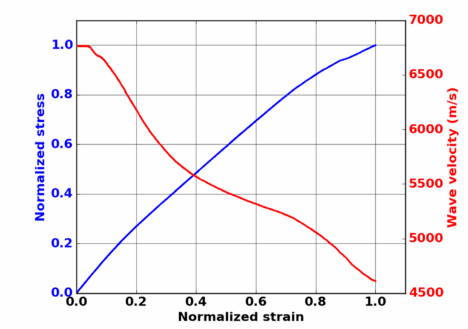
Figure 3. Evolution of the wave velocity as a function of strain during tensile test in fiber orientation on oxide–oxide